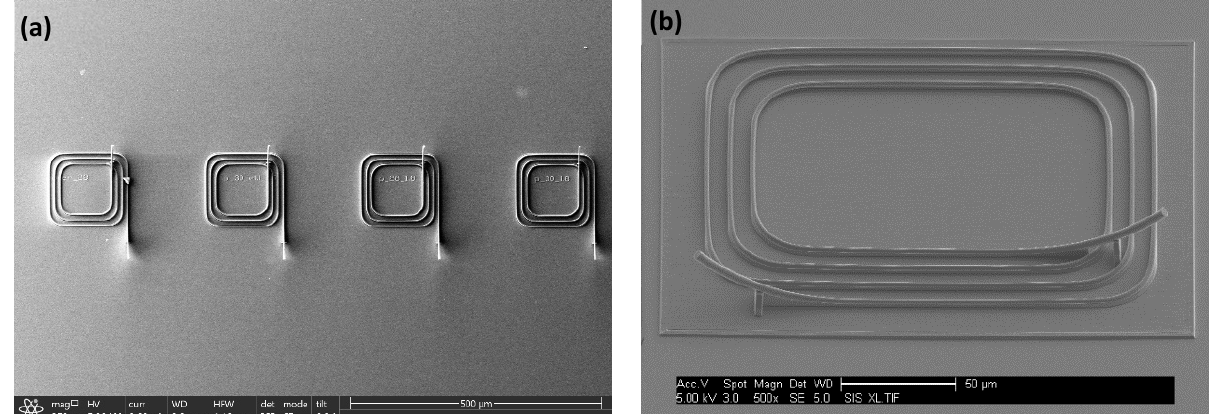
Figure 10. ( a ) HRSEM image of the fabricated spiral waveguide, consisting of four fabricated waveguide structures in parallel. ( b ) HRSEM image of the spiral-shaped waveguide, supported with a narrow fin.